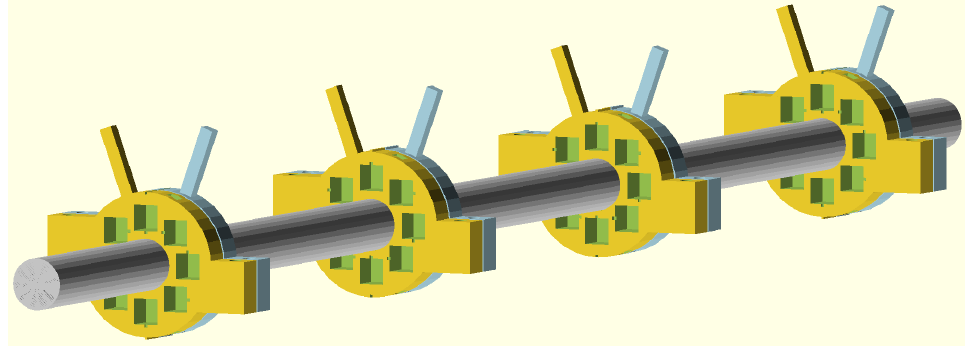
Figure 8. Sketch of the four-dipole chicane made of four double-ring variable dipole magnets strapped on a cylindrical